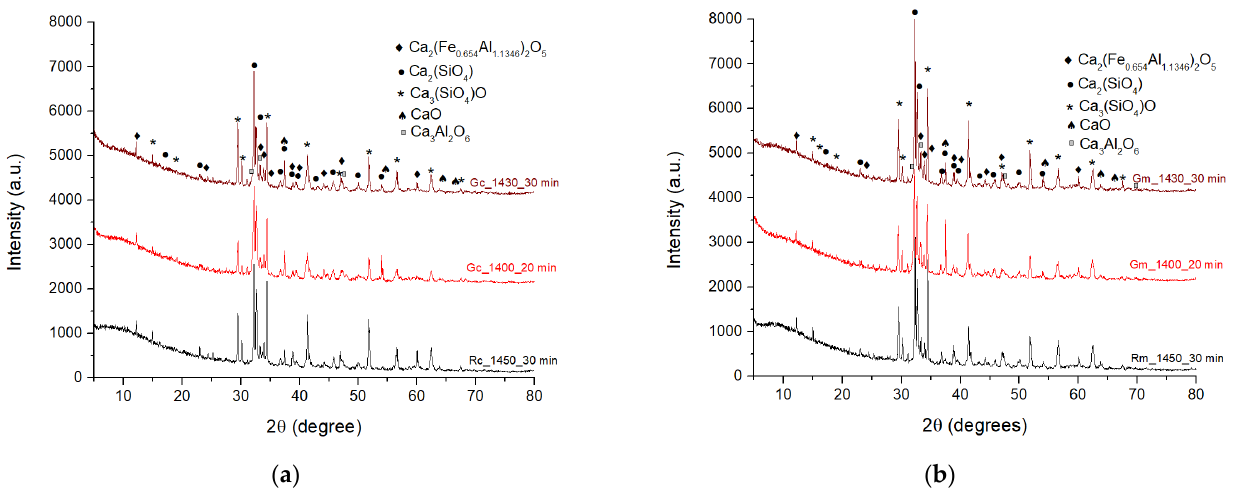
Figure 4. XRD patterns of clinkers obtained by calcination of raw mixes with/without WG content: ( a ) raw mix based on clay; ( b ) raw mix based on marl.